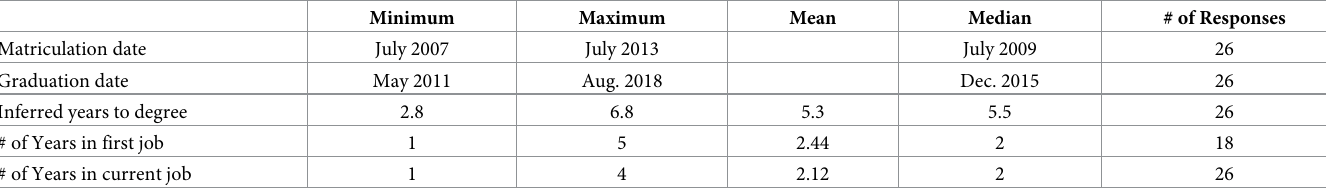
Table 1. Demographics of alumni